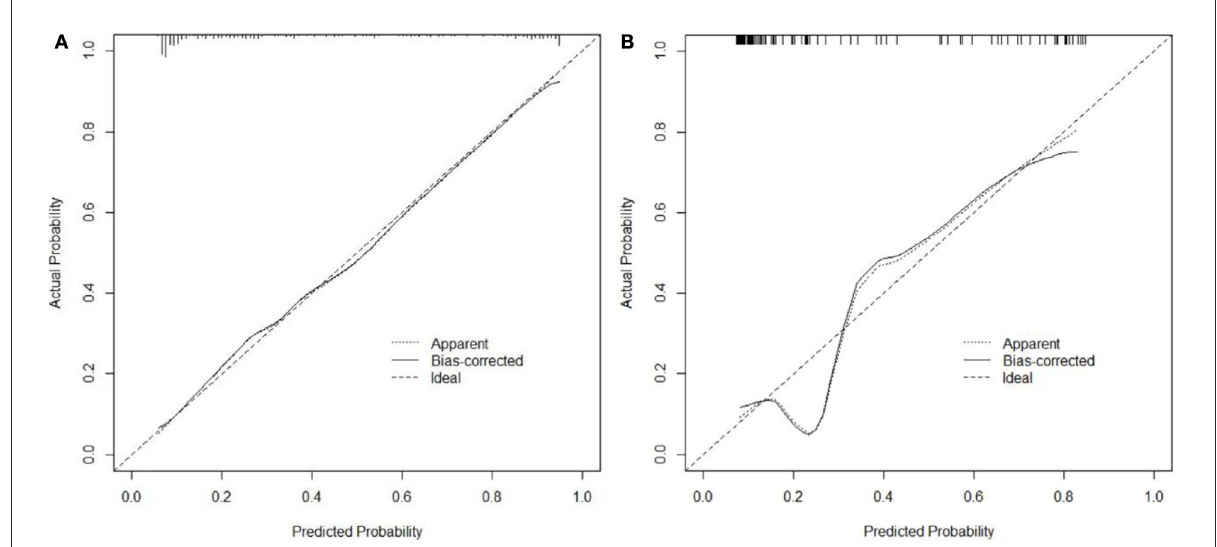
FIGURE4 Calibration curves for predicting the probability of SAP after SICH. (A) Training cohort. (B) Validation cohort.